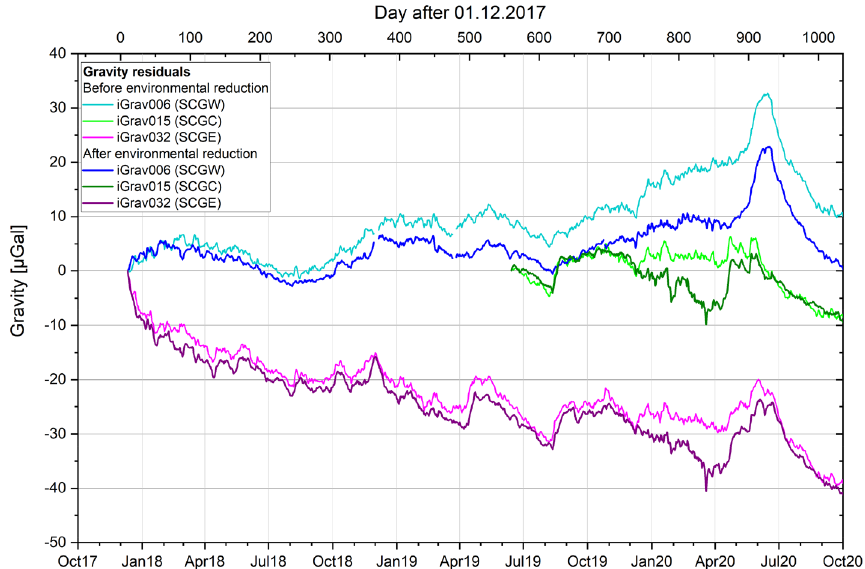
Fig. 5 Gravity residuals of the three iGravs at Þeistareykir before and after the combined reduction of environmental effects including global effects, soil water content variations, snow water equivalent and vertical surface displacement (see Figs 17, 18, 19 in the Appendix for individual environmental